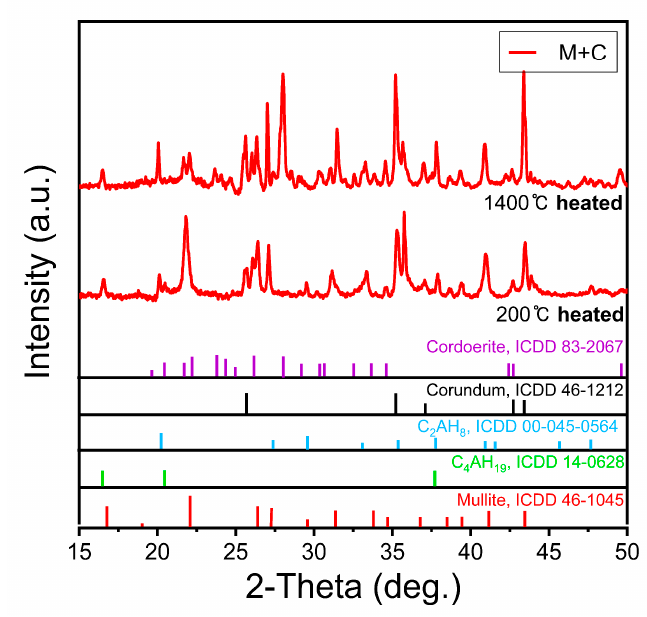
Figure 7. XRD peaks after heat treatment at 200 °C and 1400 °C of mullite sand and CAC mixed molded body.